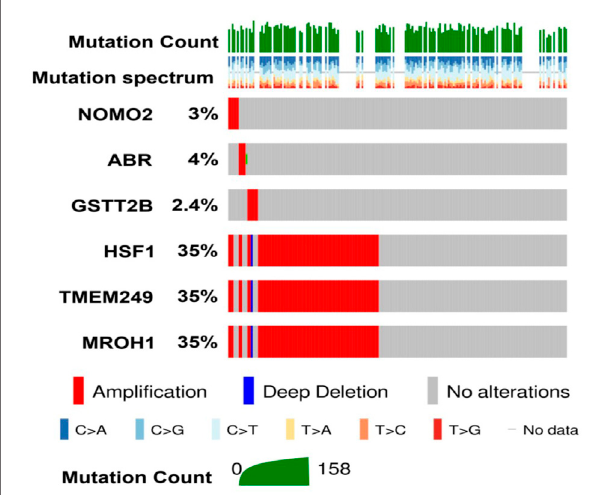
FIGURE 4 | Investigation of DNA alterations for six genes detected in NAC resistance in TCGA-ovarian cancer patients on cBioPortal. Oncoplot illustrates the ampli fi cation status of six different genes identi fi ed in resistant patients across 585 ovarian carcinoma patients from TCGA. Among